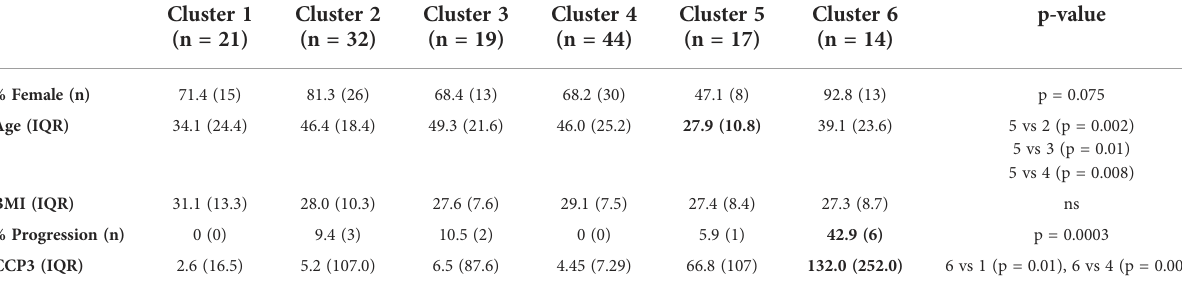
CCP3, third generation cyclic citrullinated protein antibodies; BMI, body mass index; ACPA, anti-citrullinated protein antibodies; ACPA, ACPA negative; ACPA seroconv, ACPA seroconversion,ACPA+:ACPApositive,ACPA+prog:ACPApositiveprogressor.AnalyzedbyDunn ’ stestandchi-square;correctedformultiplecomparisonswithBenjamini-Hochberg. Bold, means statistically signi fi cant vs multiple clusters. ns = not signi fi cant.